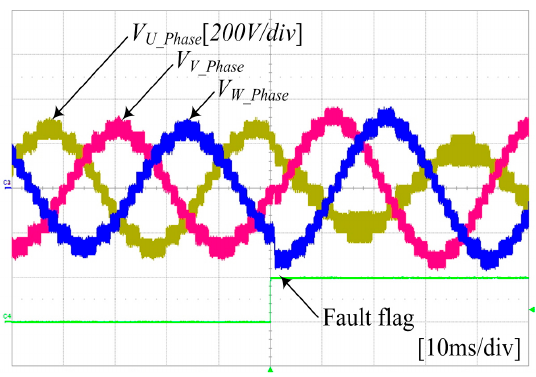
Figure 30. Experimental waveform of phase voltage applying proposed neutral-point voltage-shifting control. control.